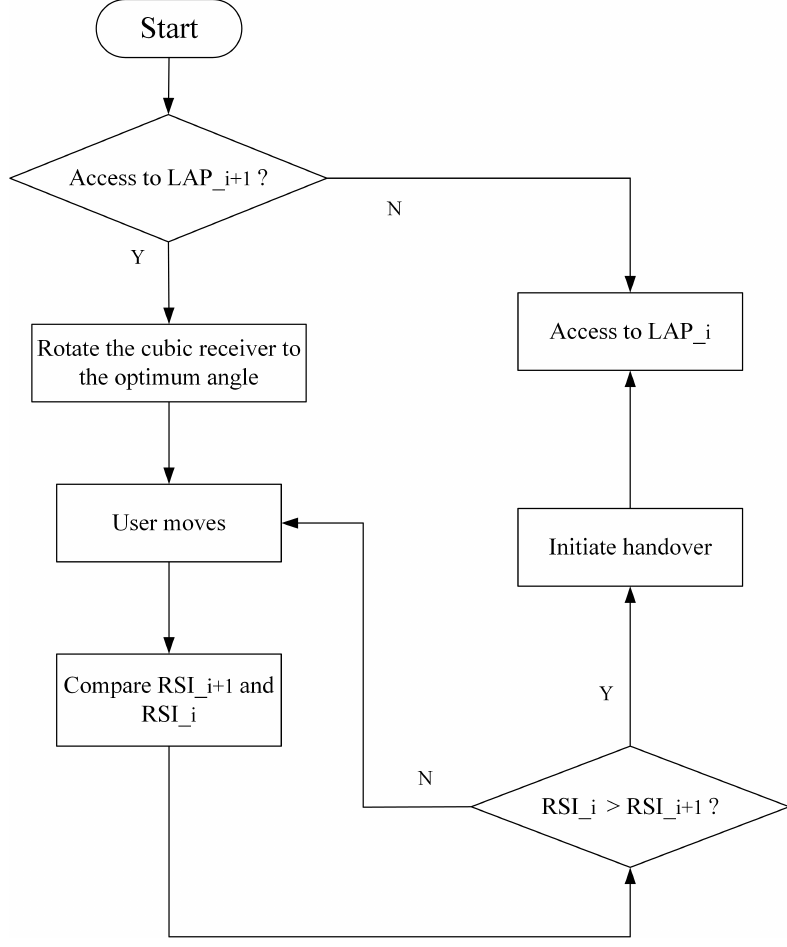
Figure 5. The flow diagram of handover.